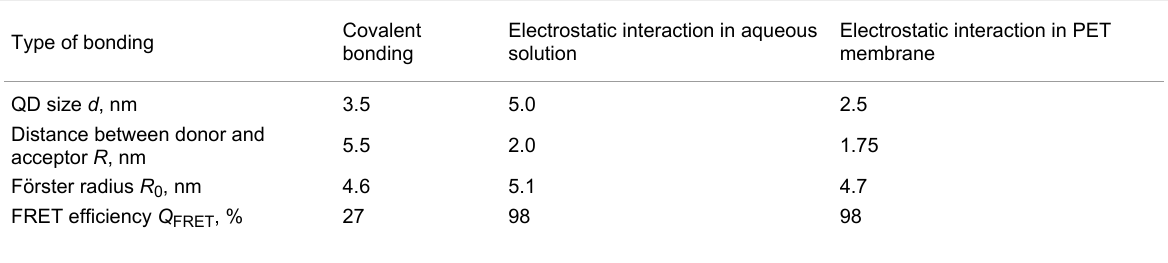
Table 2: Förster distances, R 0 and FRET efficiency, Q FRET for QD–Ce6 complexes with different QD sizes.